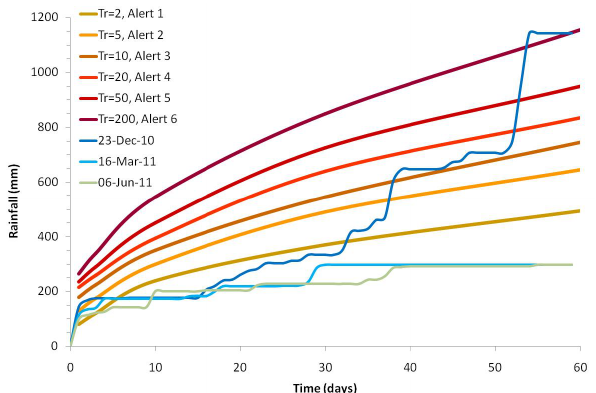
Fig. 17. Hydrological alert system for Val di Maso and 60-days rainfall cumulated backward from the most intense rainfall events after the November 2010 flood. The 23 December 2010 and 16 March 2011 events induced displacements measured by exten- someters placed in the crown